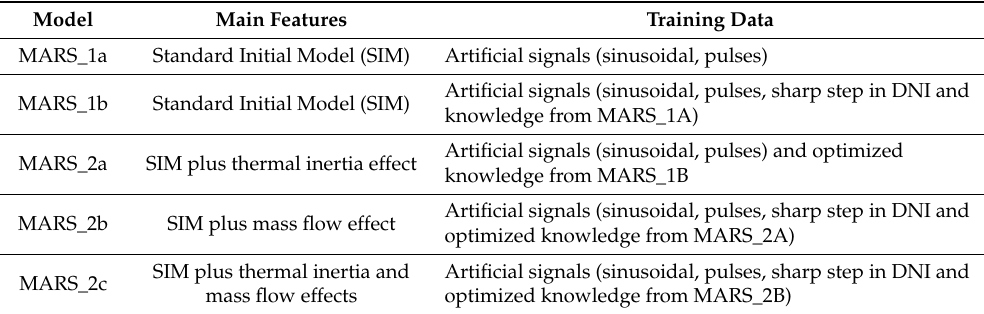
Table 2. Multivariate adaptive regression splines (MARS) models.